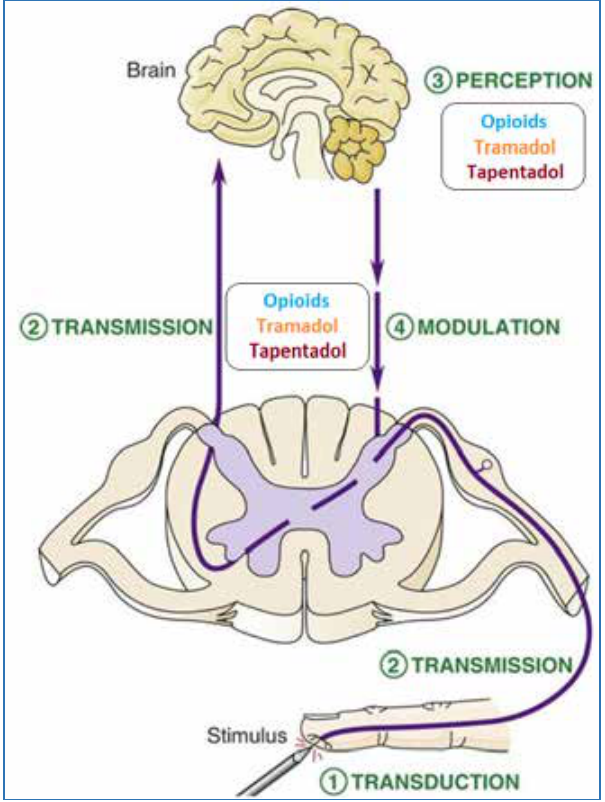
Figure 2: Opioid, tramadol, and tapentadol targets (adapted from Marsh 22